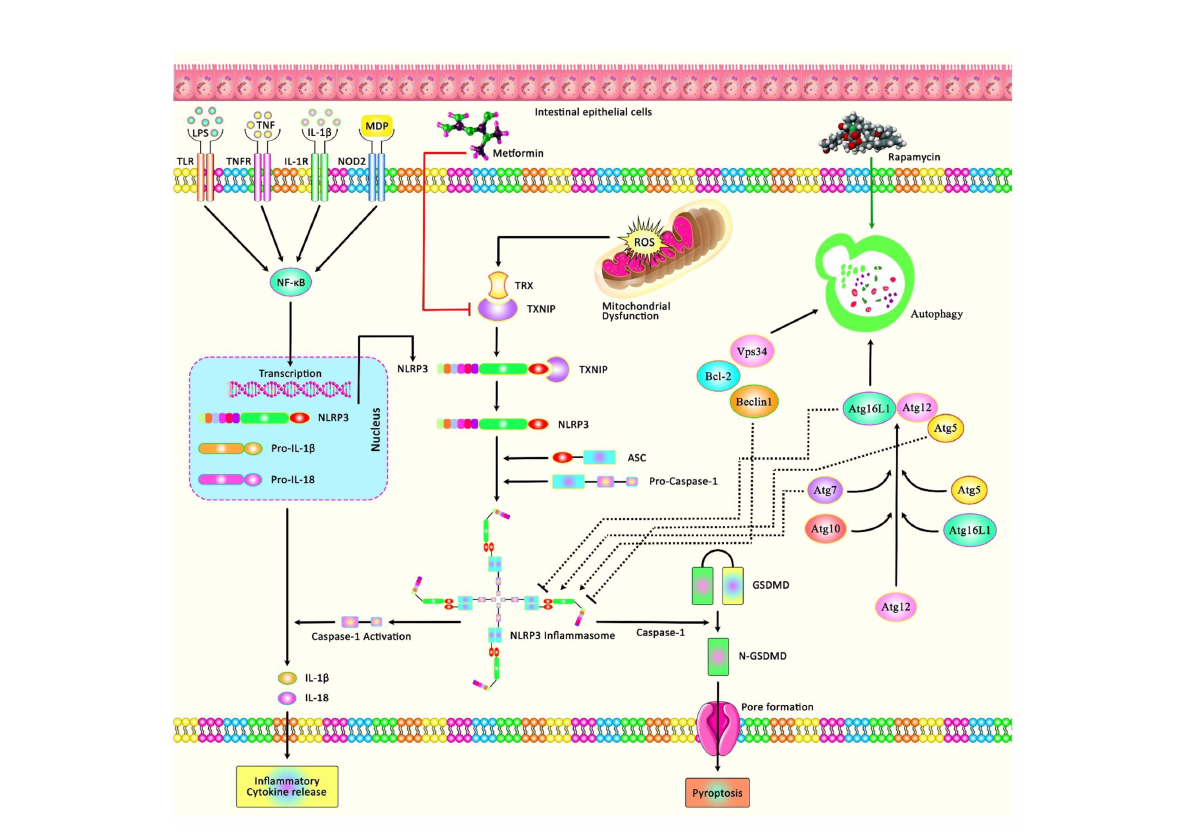
FIGURE 2 A schematic diagram of the role of NLRP3 involved in I/R Injury in intestine. Mounting evidence has demonstrated that inappropriate activation of NLRP3 could play an effective role in the progression of I/R injury in the intestine by creating an intracellular multi-protein complex known as NLRP3 in fl ammasome. As an illustration, a recent study has detected that Metformin could protect against intestinal I/R injury and decrease oxidative stress and the in fl ammatory response via downregulating pyroptosis-related proteins, containing NLRP3, active caspase-1, N-GSDMD, and the expression of TXNIP as well as the interaction between TXNIP and NLRP3 (20). Moreover, another research has fi gured out that Rapamycin through inducing the process of autophagy could attenuate intestinal I/R induced NLRP3 in fl ammasome activation